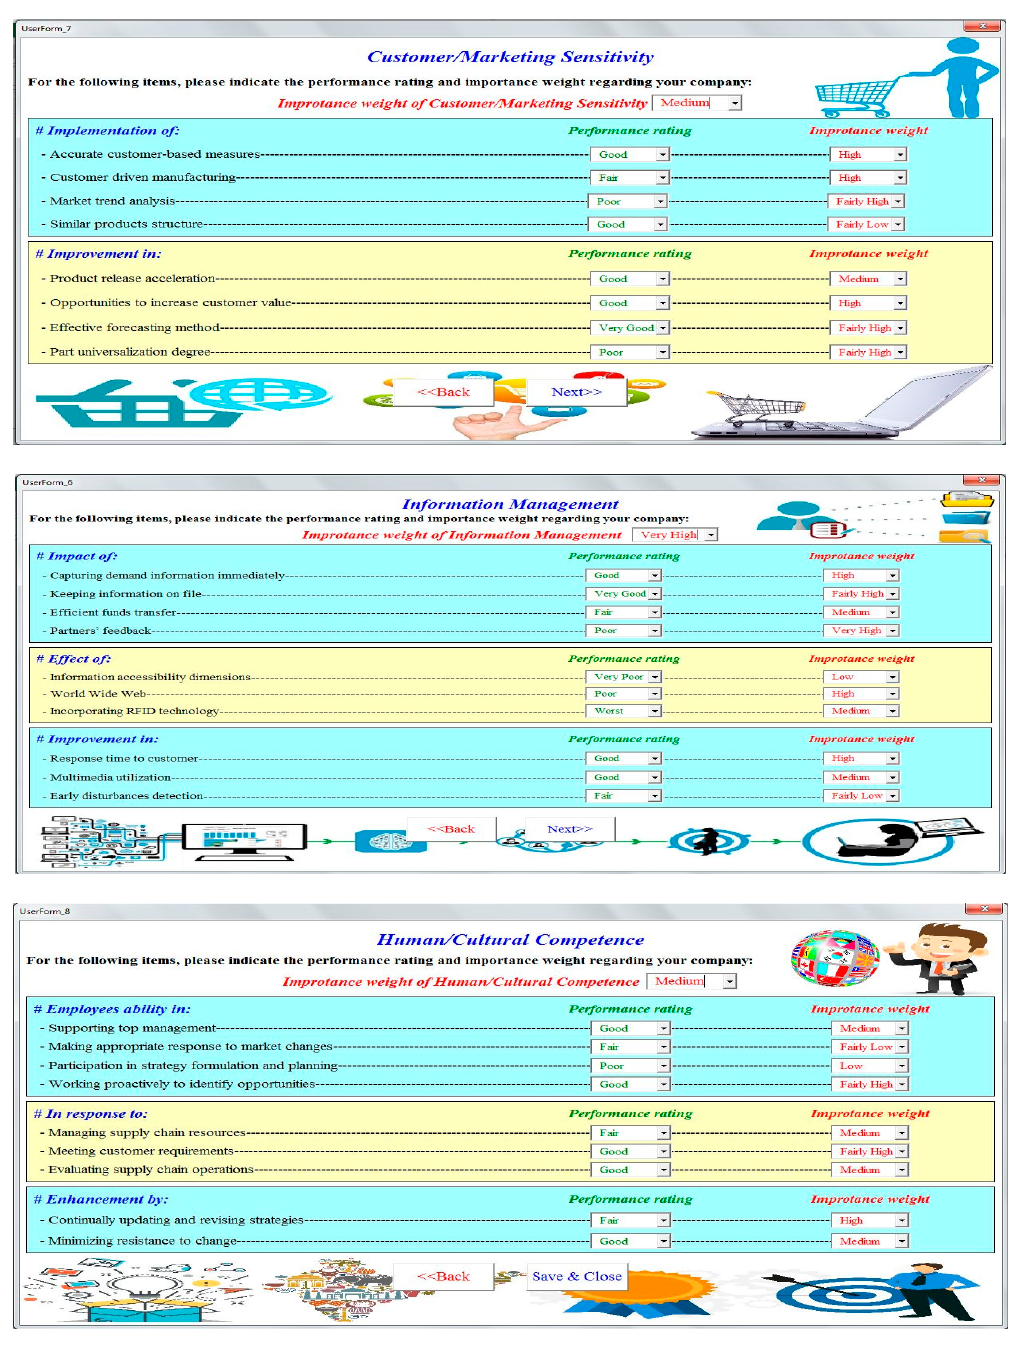
Figure 2. Screenshots of the “Response” interface.